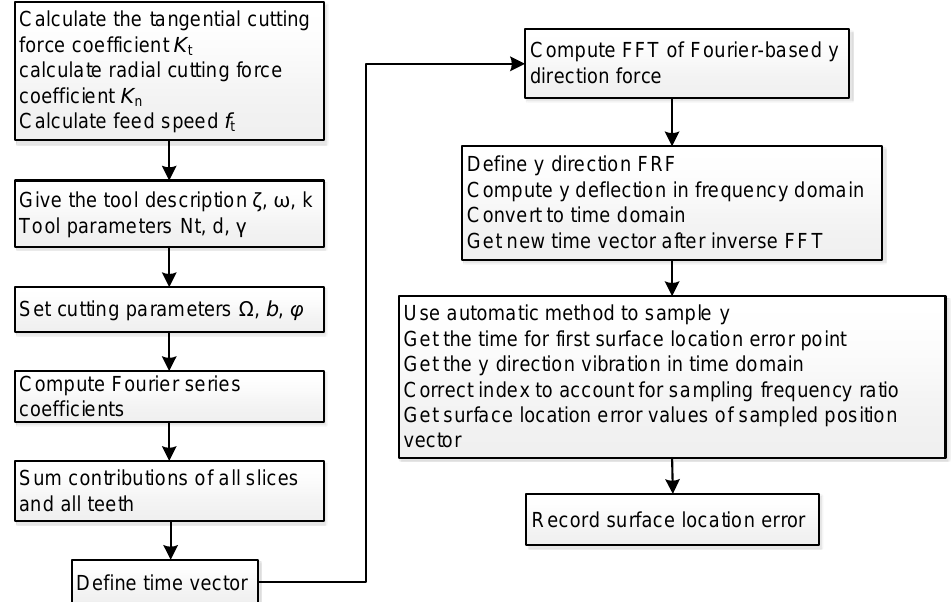
Figure 3. Calculation process of surface location error variation with axial location.